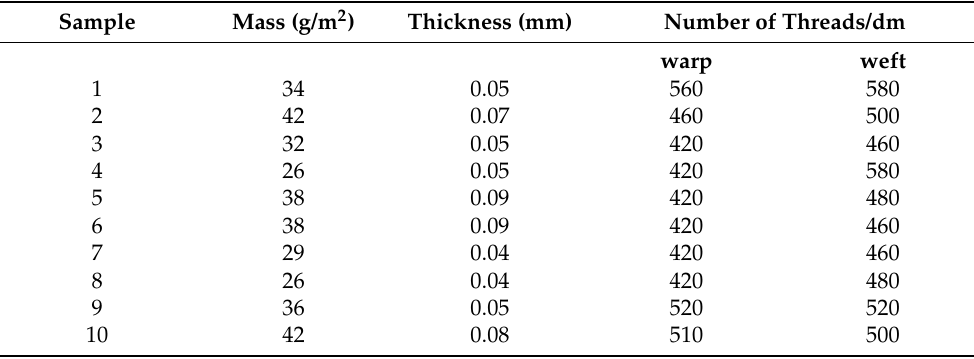
Table 1. Basic characteristics of the analyzed